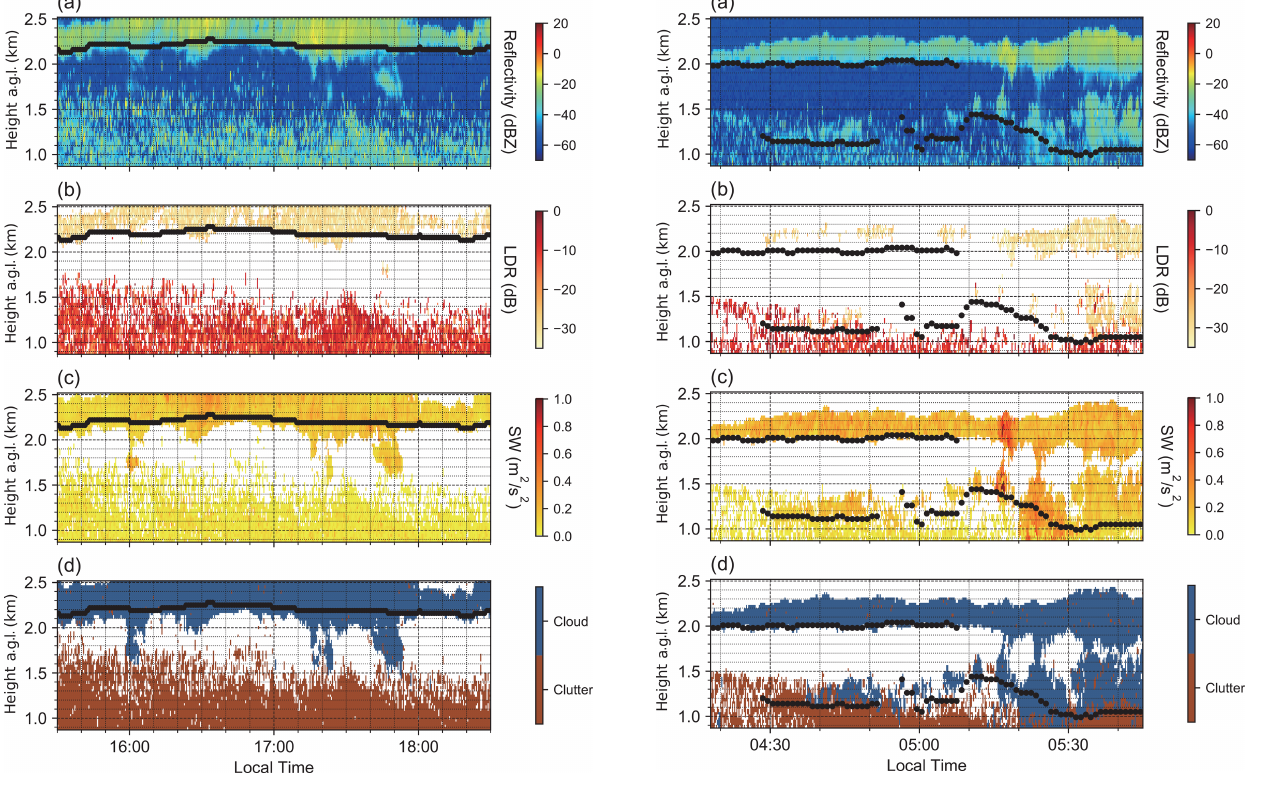
Figure 11. Same as Fig. 8 but for 04:18 to 05:45LT on 20 July